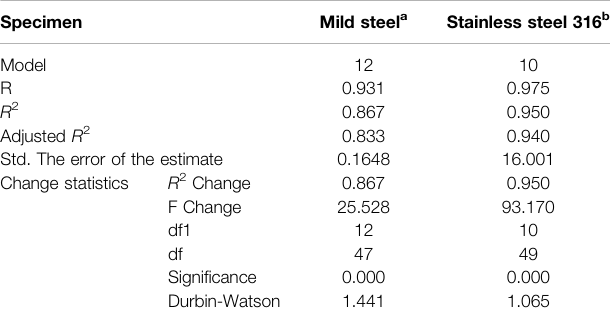
TABLE 8 | Model summary for developing the regression model for mild steel and stainless steel 316 corrosion